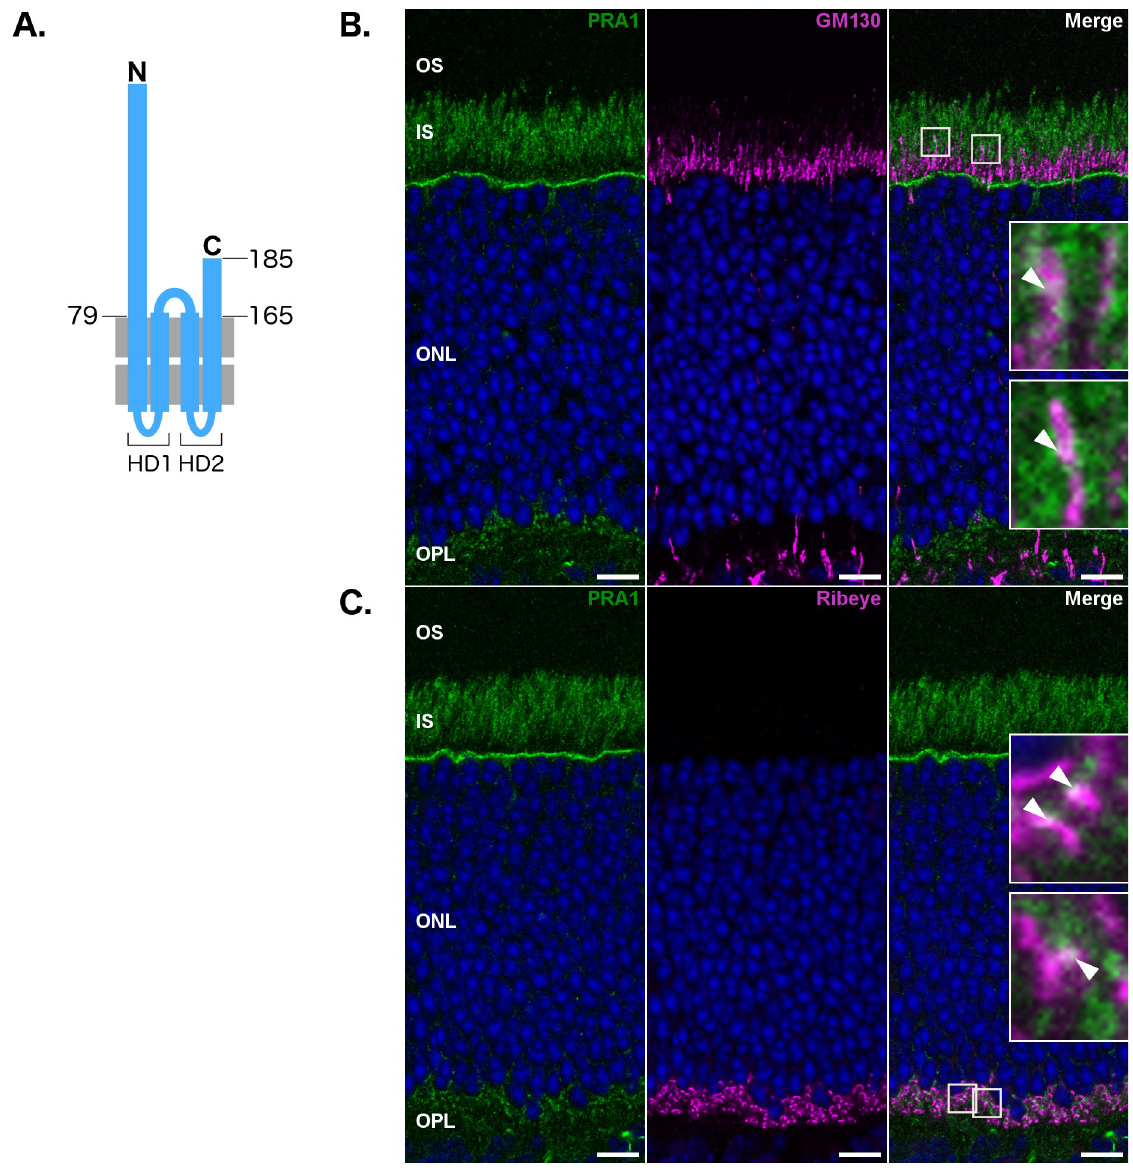
Fig 1. Endogenous PRA1 does not strictly localize to the Golgi in mature C57Bl/6J photoreceptor cells. (A) Schematic showing PRA1 topology. (B) PRA1 partially co-localizes with both the Golgi marker GM130, and the ribbon synapse marker Ribeye (C) as indicated by solid arrowheads. Images are representative of three non-adjacent sections from four retinas and are compiled from a single 1 μ m z-section. Insets are nine-fold magnifications of an area within the displayed images, highlighted with a dashed-line. Scale bar: 10 μ m. Green: PRA1, Magenta: Organelle markers, Blue: Nuclear labeling via TO-PRO-3, White: Co-localization, OS: Outer segment, IS: Inner segment, ONL: Outer nuclear layer, OPL: Outer plexiform layer.